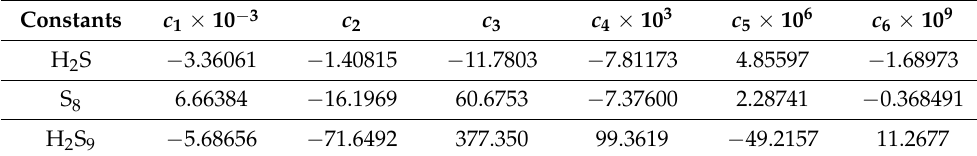
Table 2. Standard chemical potential constants.